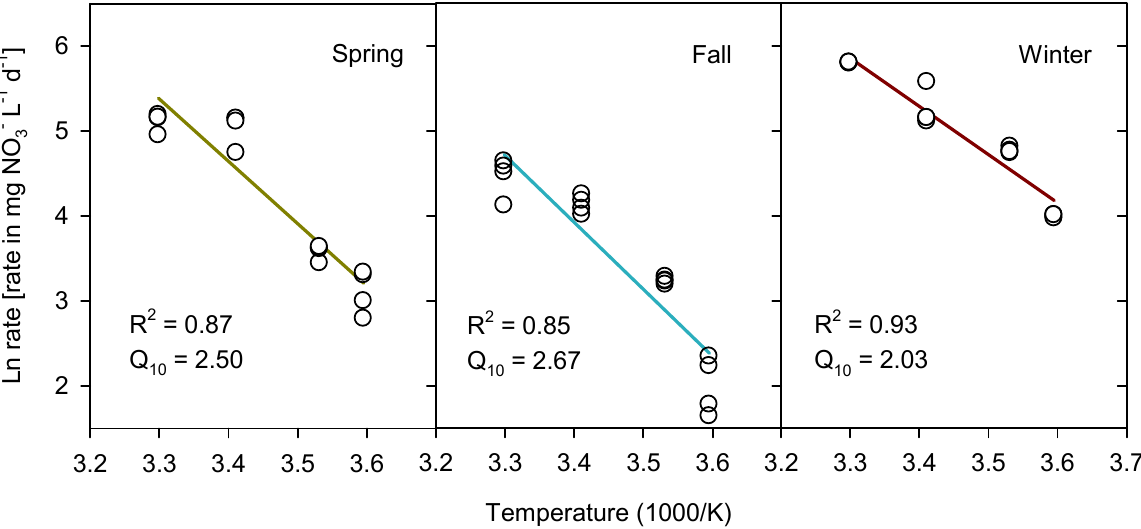
Figure 2. Arrhenius plots of the temperature effect on nitrate (NO 3 − ) removal rates in enrichments from woodchip bioreactor samples from three different seasons (spring, fall and winter). Lines show linear regression between data points (circles). Coefficients of determination ( R 2 ) and temperature coefficients ( Q 10 ), calculated from Arrhenius activation energies, are shown.